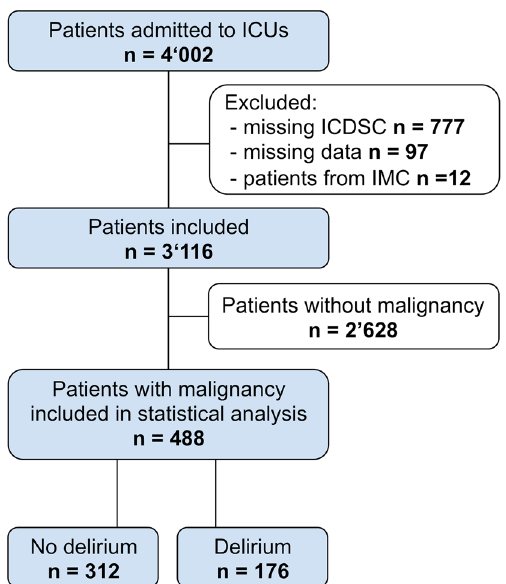
Figure 1. Study flowchart. ICDSC intensive care delirium screening checklist, ICU intensive care unit, IMC intermediate